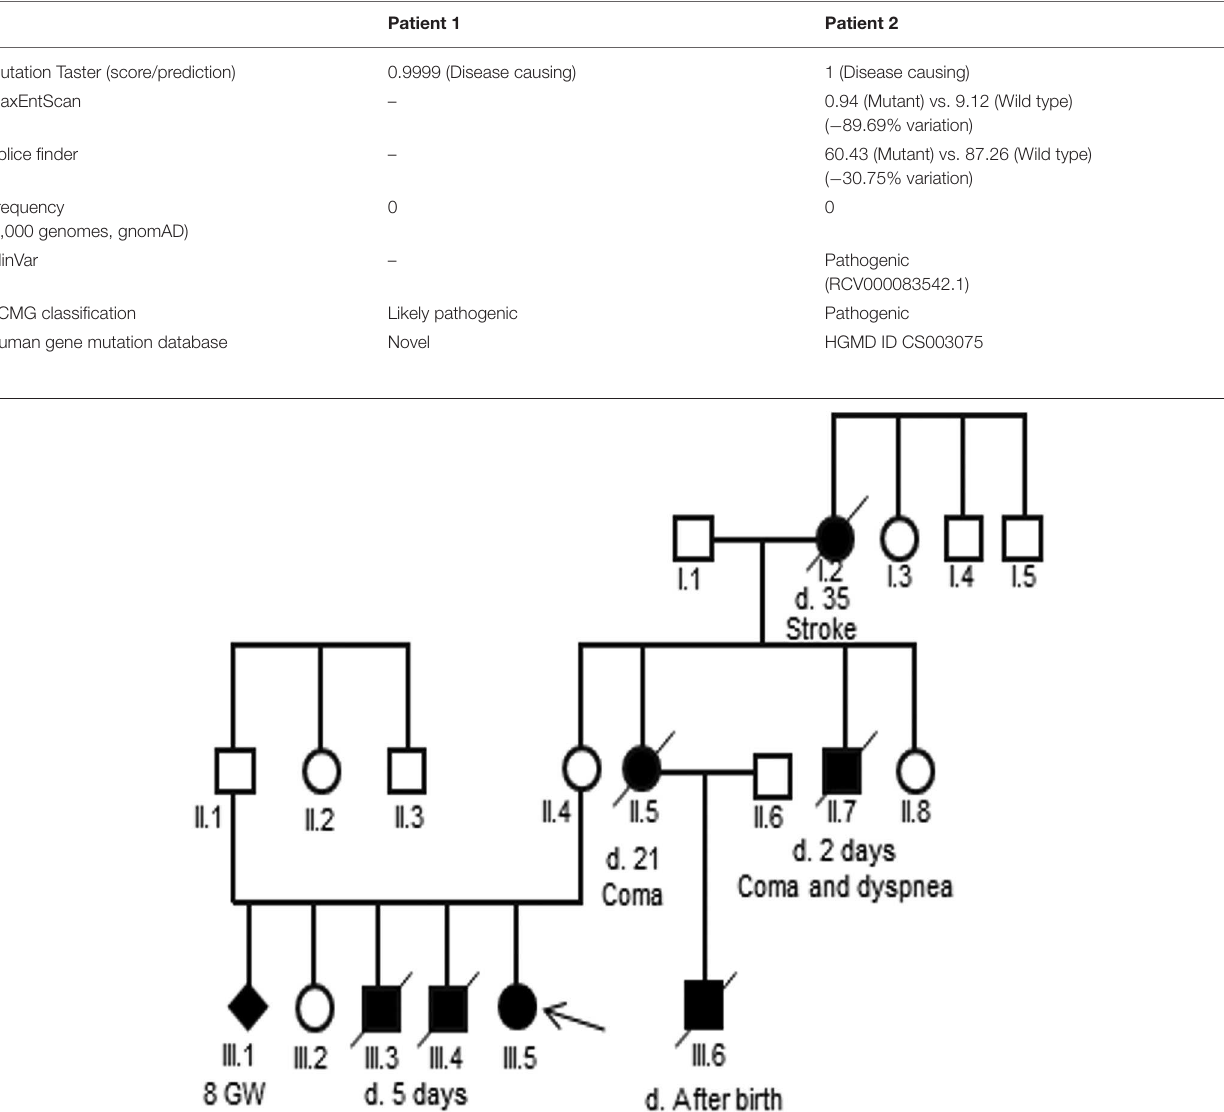
of hyperammonemia. Hemofiltration was performed to reduce the blood ammonia level. She was the fourth child of non- consanguineous Vietnamese parents. Her birth weight was 2.9 kg at 38 weeks of gestation. She had normal development at the time of